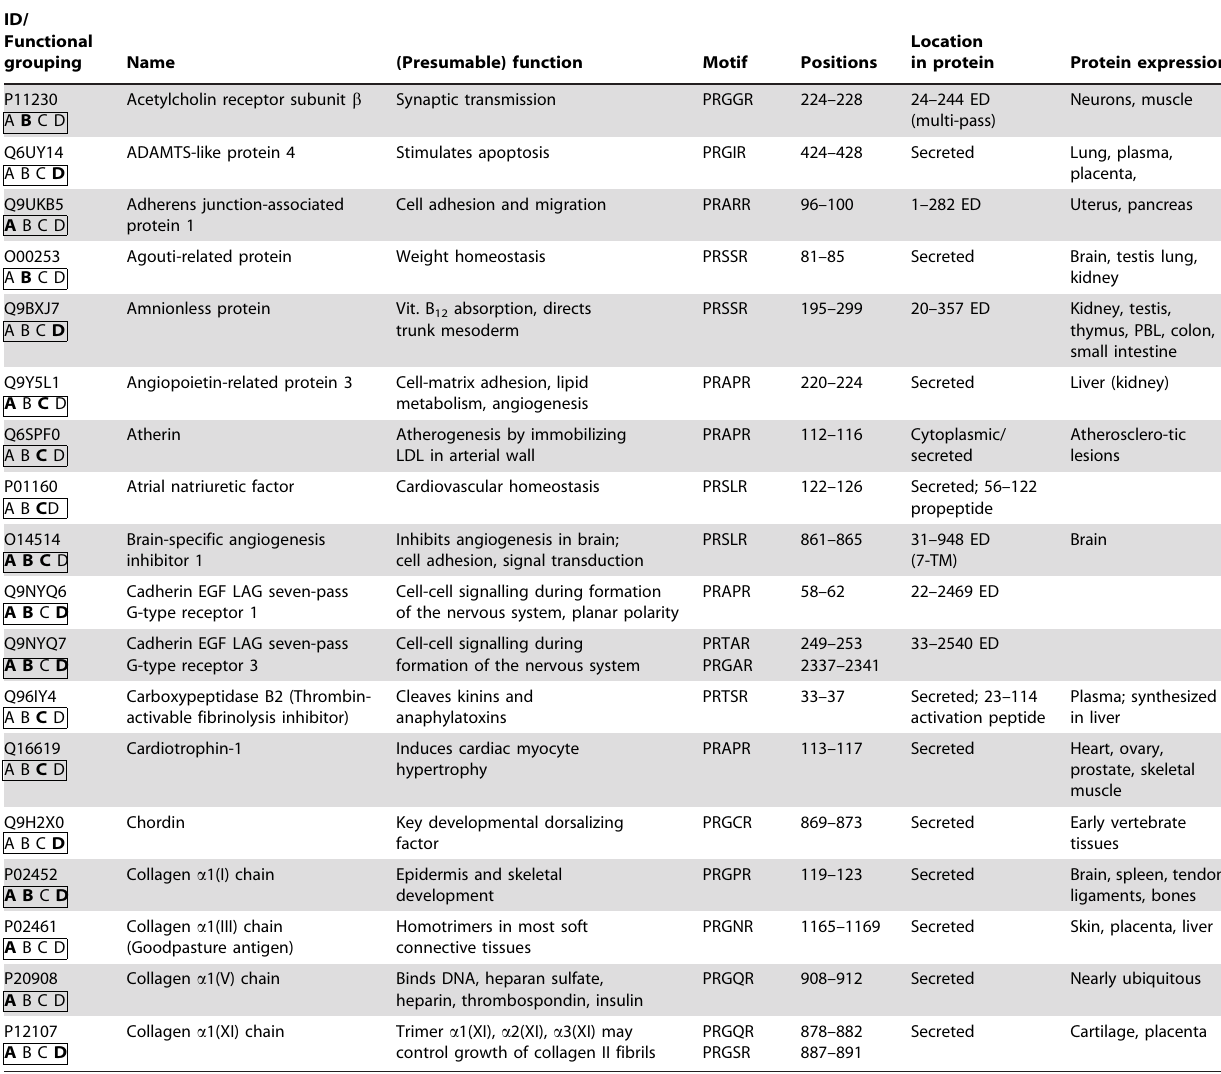
Table 3. Potential novel thrombin